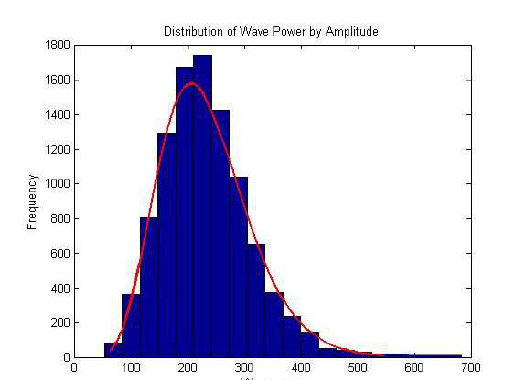
Figure 9. Eq.5 Wave Power Distribution